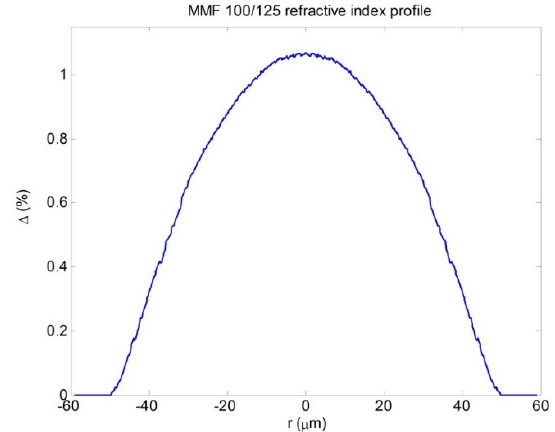
Figure 2. Reference graded refractive index profile reconstructed by a report of real laser-optimized multimode fiber (LOMF) sample profile measurements and scaled up to a 100 μm core.